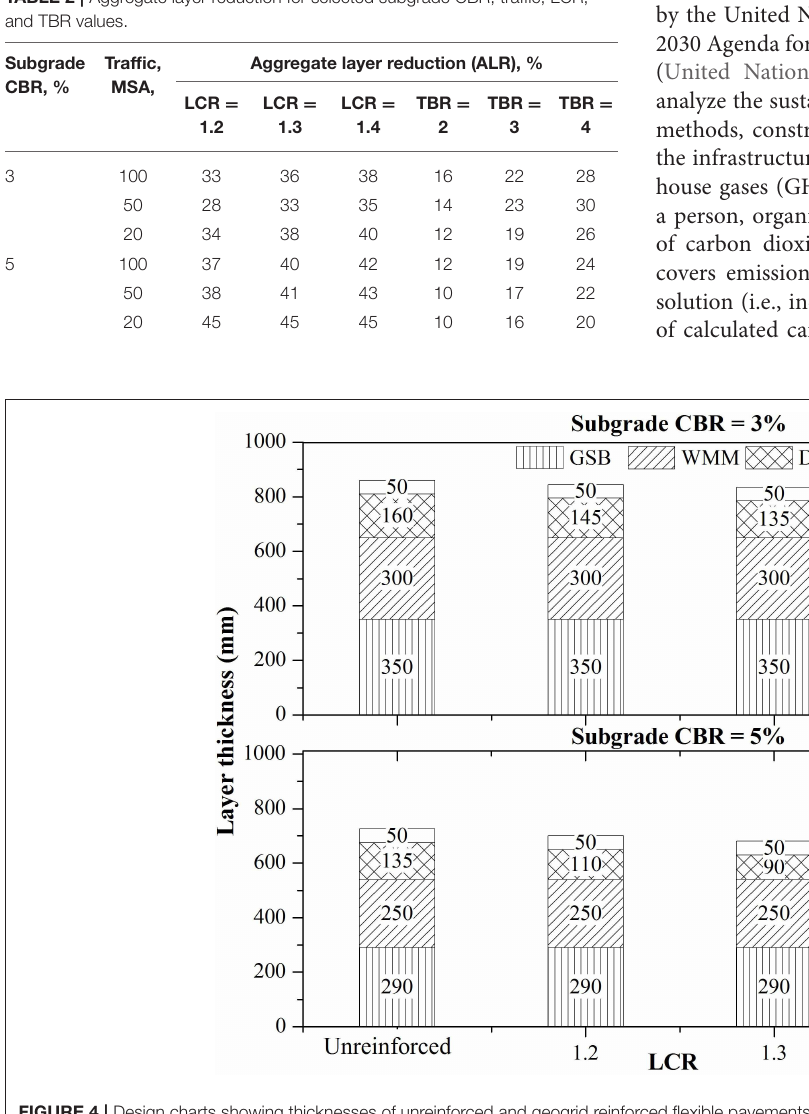
Frontiers in Built Environment |